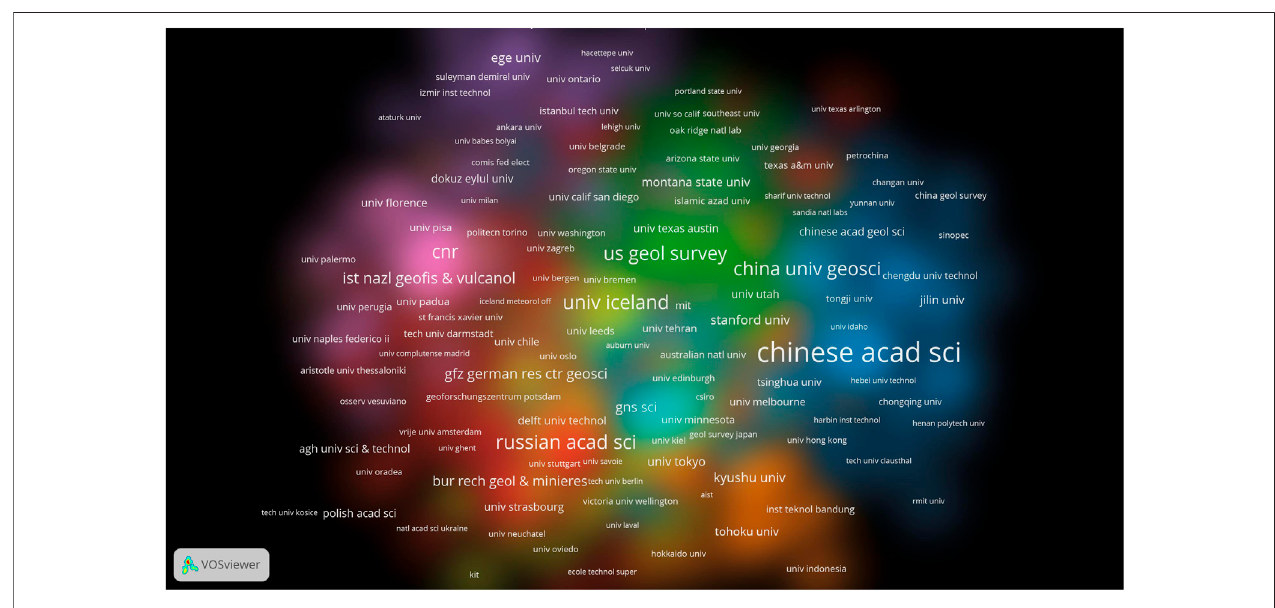
FIGURE 5 | Density view of co-authorship of